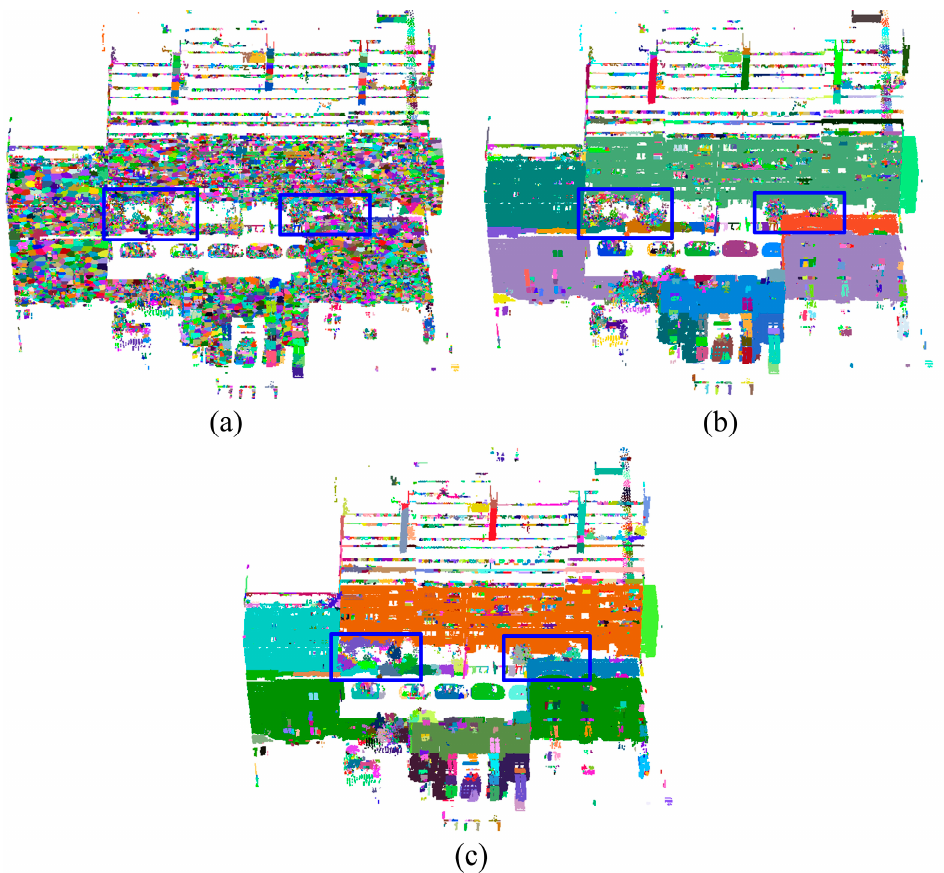
Figure 4. The views of each step in IN-Graph segmentation. ( a ) Multi-scale supervoxel of the point cloud. ( b ) Results of the graph cut. ( c ) Results of the inverse label operation.